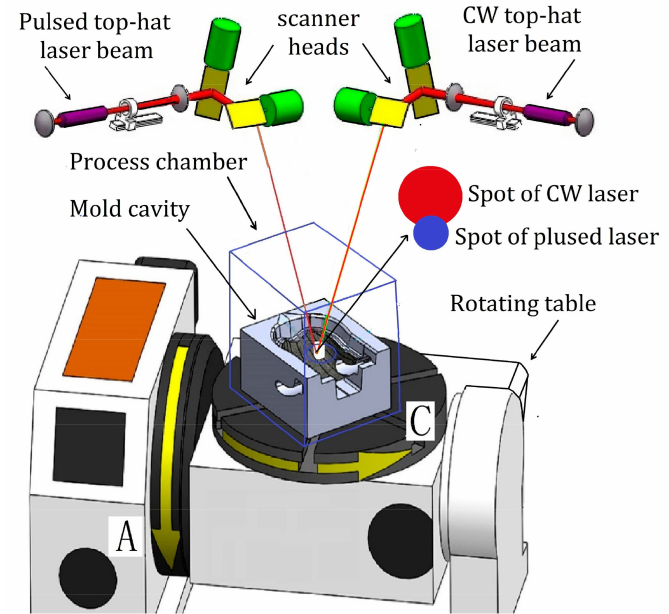
Figure 5. Dual-beam laser polishing